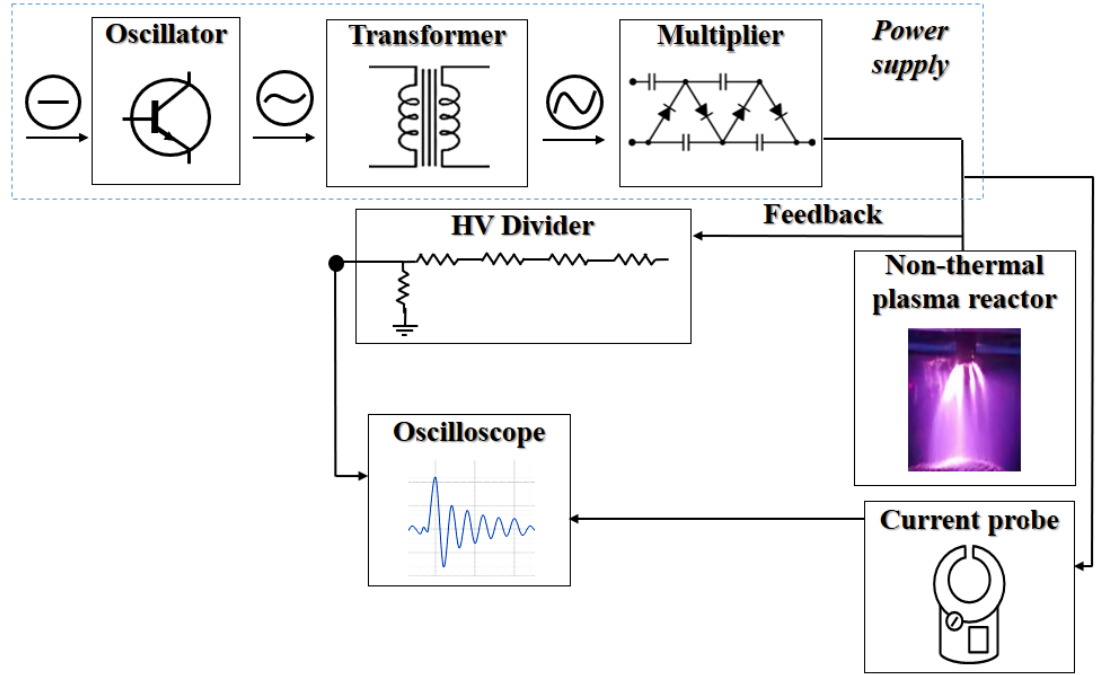
Figure 2. Experimental configuration of NTP system proposed in this study .